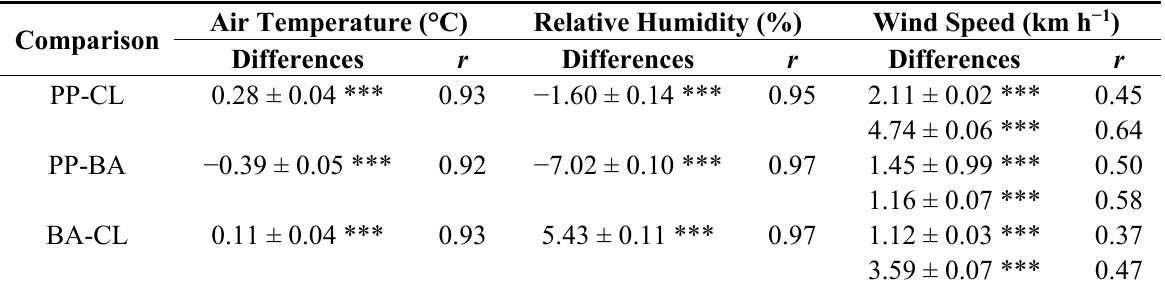
Table 3. Weather variables hourly observations: differences (mean ± std. error) and correlations ( r ) within pairs of forest stands, with the significance of the Wilcoxon signed-rank test; n = 2446 except for temperature comparisons involving BA ( n = 2269); values reported for wind speed correspond, respectively, to the mean and the maximum. Comparison